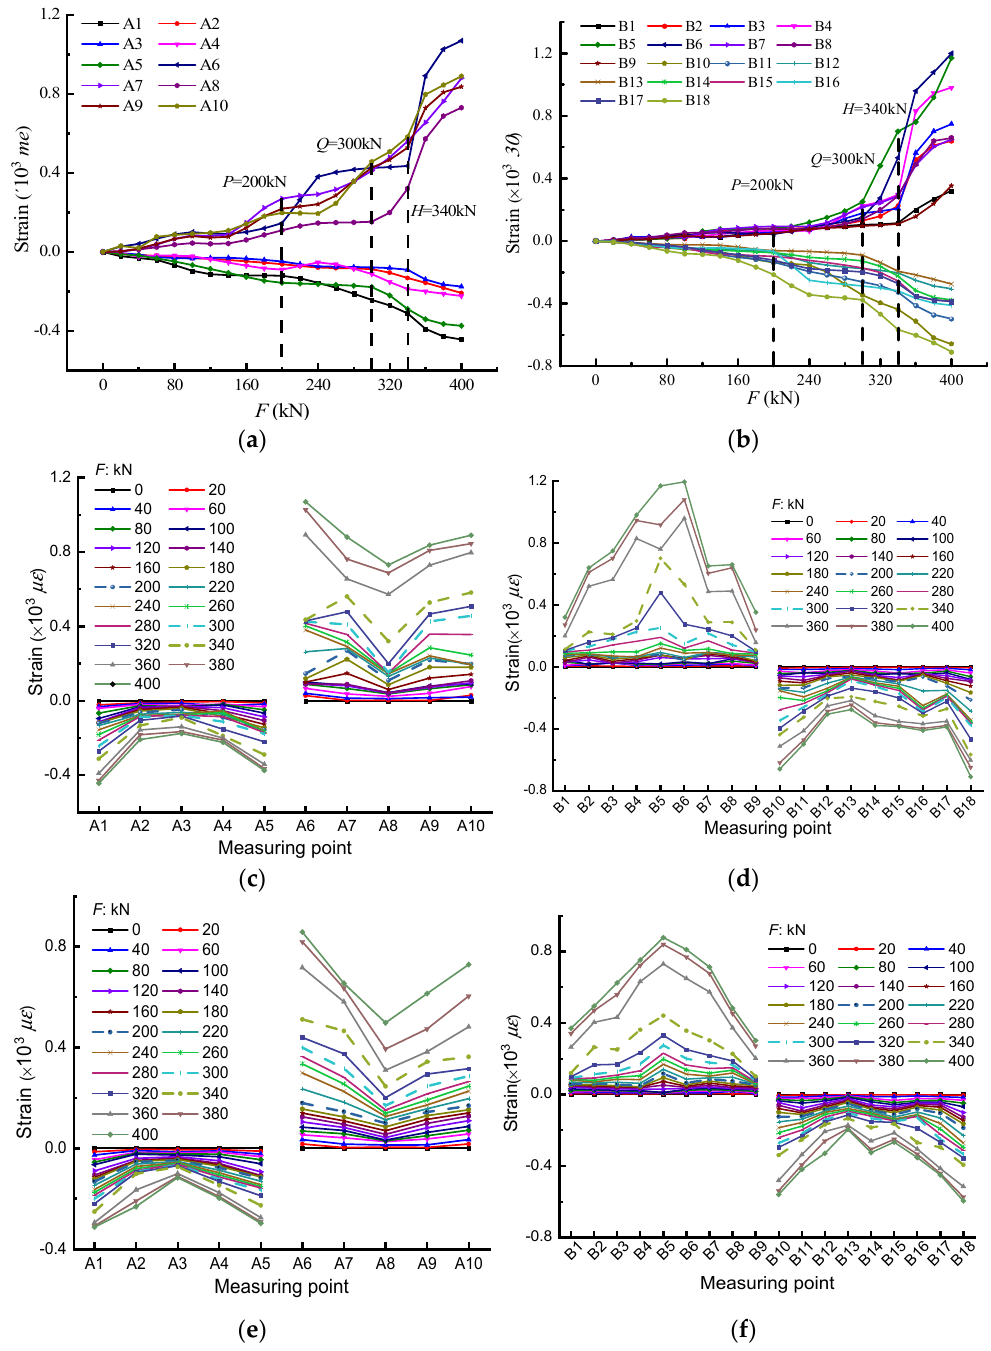
Figure 7. The changing characteristics of strain-based stressing state modes: the trend changing characteristics of strain-based stressing state mode of ( a ) section A; ( b ) section B in the experiment; the distribution pattern changing characteristics of strain-based stressing state modes of ( c ) section A; ( d ) section B in the experiment; ( e ) section A; and ( f ) section B in the simulation.